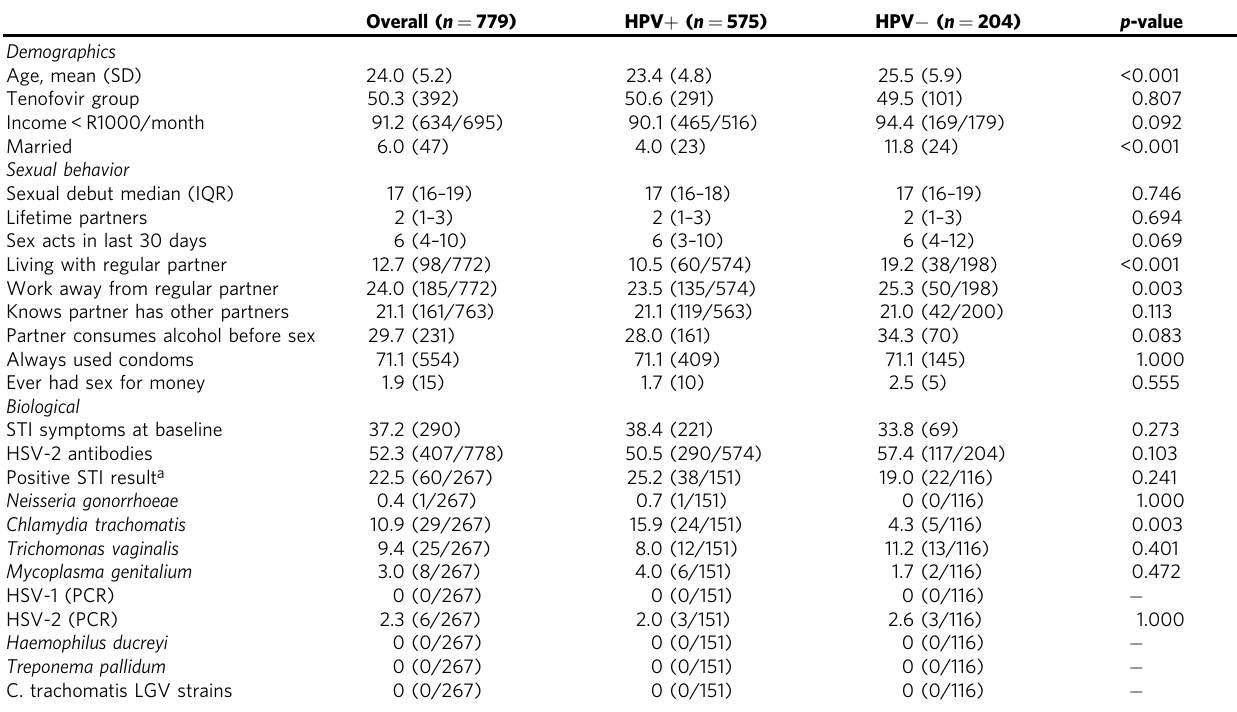
Table 1 Baseline characteristics